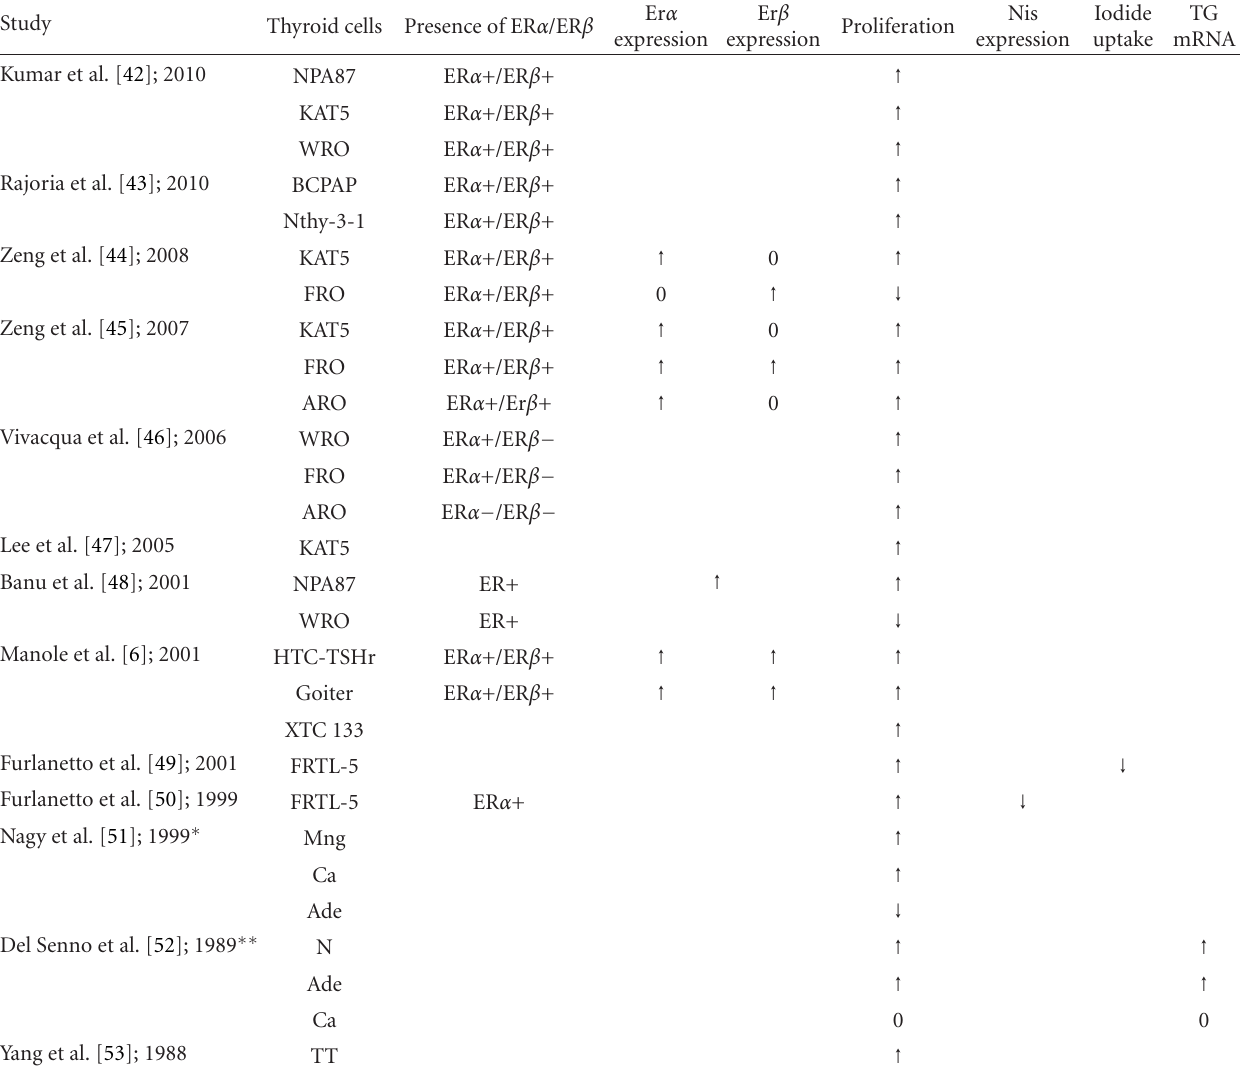
Table 3: E2 e ff ects on thyroid protein expression, function, and proliferation in